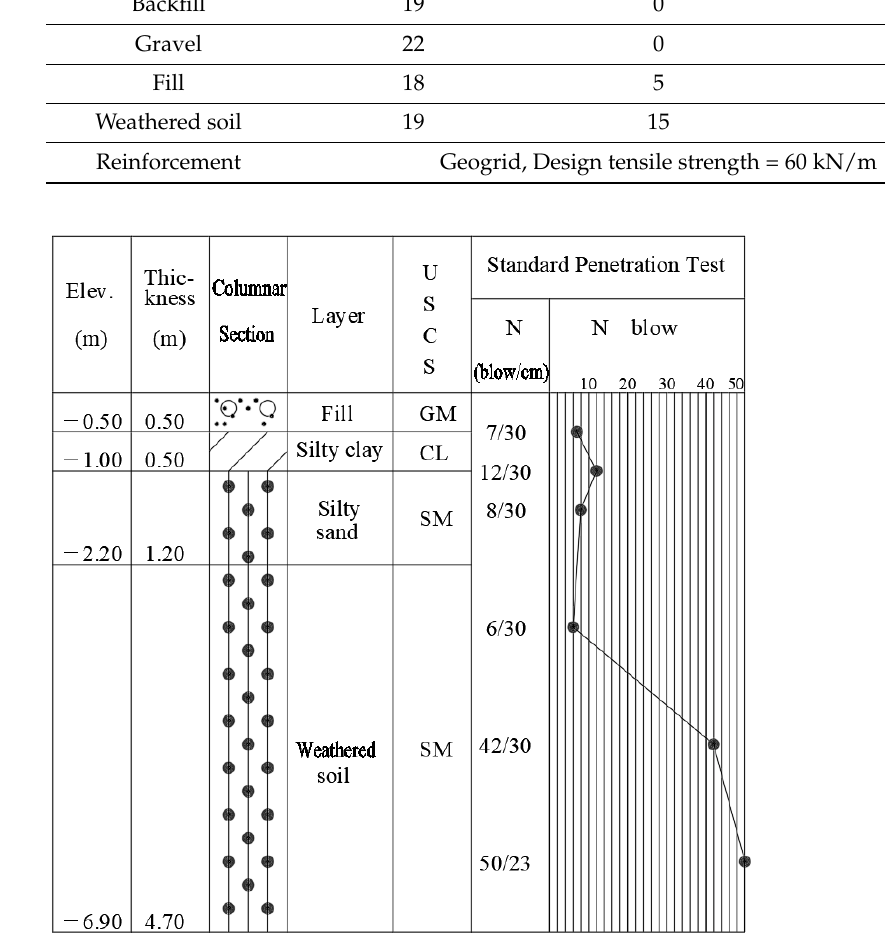
Table 2. Test result of backfill soils.